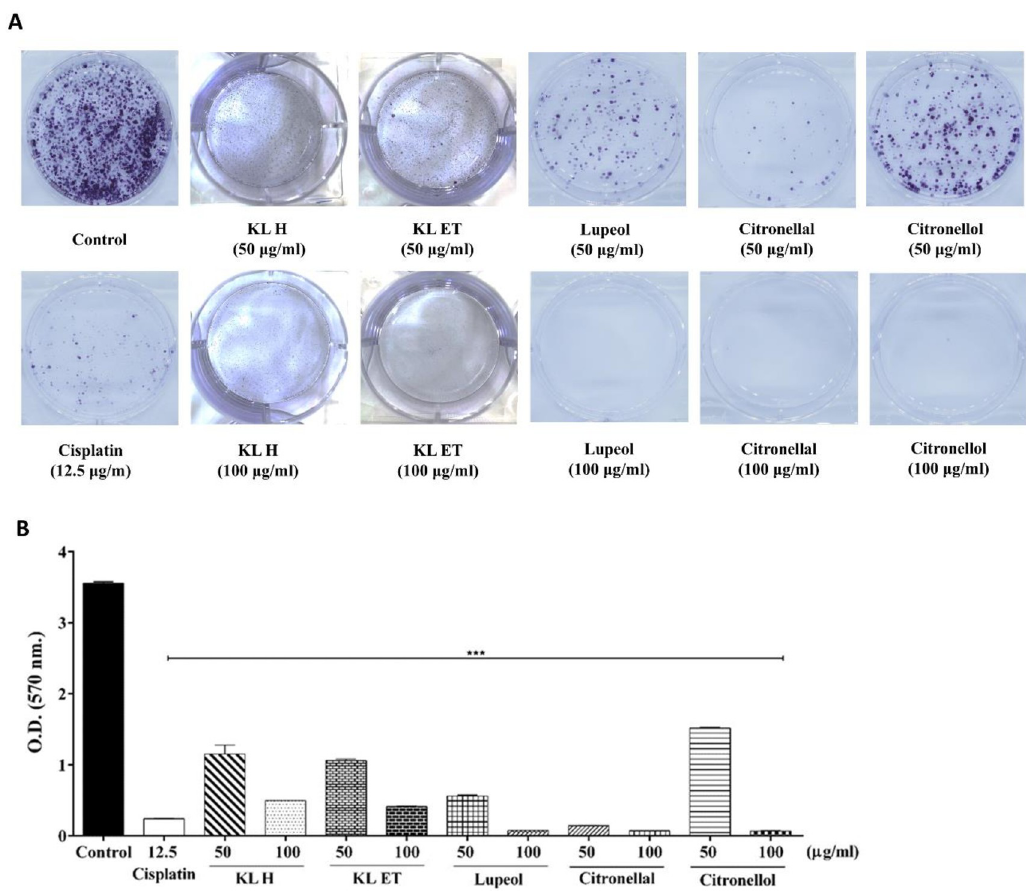
Fig 4. Colony formation of SCC15 cell line performed in 6-well plates, with cells stained with crystal violet. (A) Colony formation of untreated control and cells treated with cisplatin, crude extracts and compounds for 24 hours. (B) Colony quantification was measured by a microplate reader at OD 570 nm. Data are presented as means ± SEM. ��� p � 0.001 compared to the control. KL H: Crude hexane; KL ET: Crude ethanolic extract.